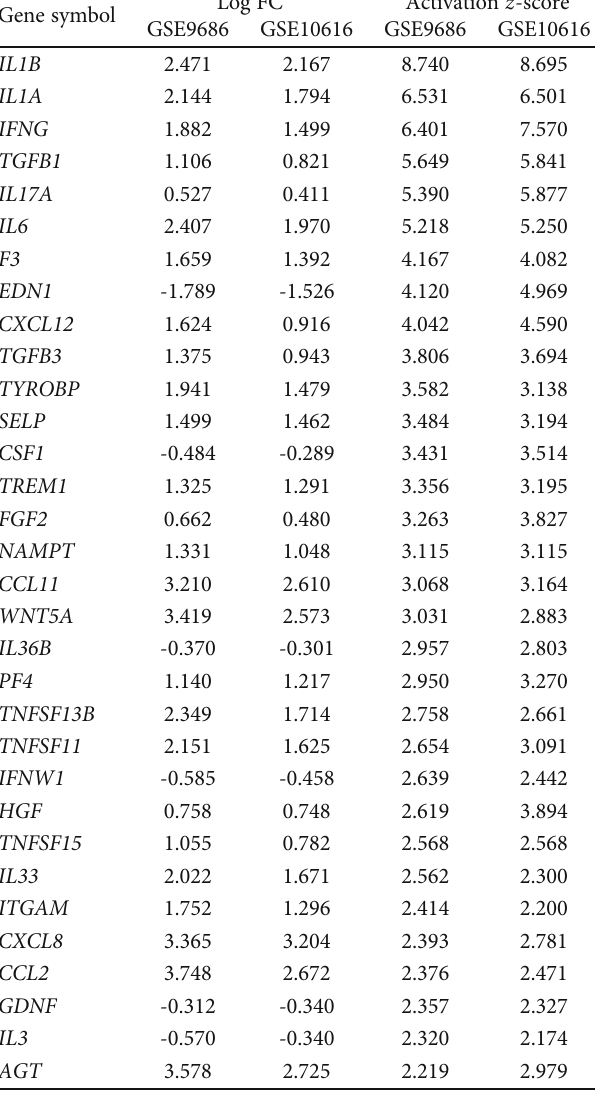
Table 3: List of di ff erentially expressed predicted upstream regulators (excluding